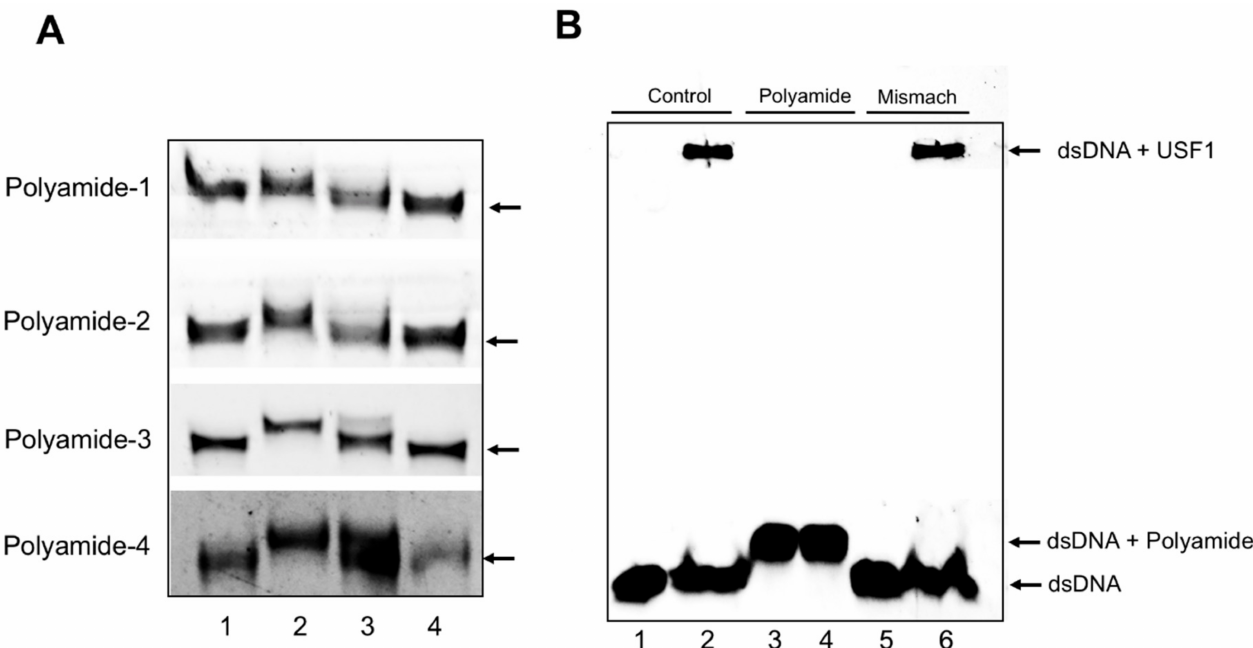
Figure 1. Gel mobility shift and DNA binding assays for upstream stimulatory factor 1 (USF1) pyrrole-imidazole (PI) polyamides. We synthesized 21-mer sense oligonucleotide and antisense oligonucleotide for USF1 PI polyamides (Polyamide- 1, -2, -3 and -4). Two oligonucleotides were denatured by heating at 95 ◦ C and then slowly cooled for annealing with each other. ( A ) The double-strand oligonucleotides and the same concentration of PI polyamide dissolved in dimethyl sulfoxide were incubated in binding buffer. Lane 1: FITC-dsDNA (10 − 5 M), Lane 2: FITC-dsDNA (10 − 5 M) + USF1 PI polyamides (10 − 5 M), Lane 3: FITC-dsDNA (10 − 5 M) + excessive dsDNA (10 − 3 M) + USF1 PI polyamide (10 − 5 M), Lane 4: FITC-dsDNA (10 − 5 M) + mismatch PI polyamide (10 − 5 M). Arrows indicate the basal position of the dsDNA. ( B ) FITC-dsDNA was incubated with Polyamide − 3 with or without USF1 protein for 30 min at 37 ◦ C and loaded onto a 20% polyacrylamide gel. Lane 1: dsDNA, Lane 2: dsDNA with USF1, Lane 3: DNA with polyamide-3, Lane 4: dsDNA with polyamide-3 and USF1 protein, Lane 5: dsDNA with mismatch, Lane 6: dsDNA with mismatch and USF1